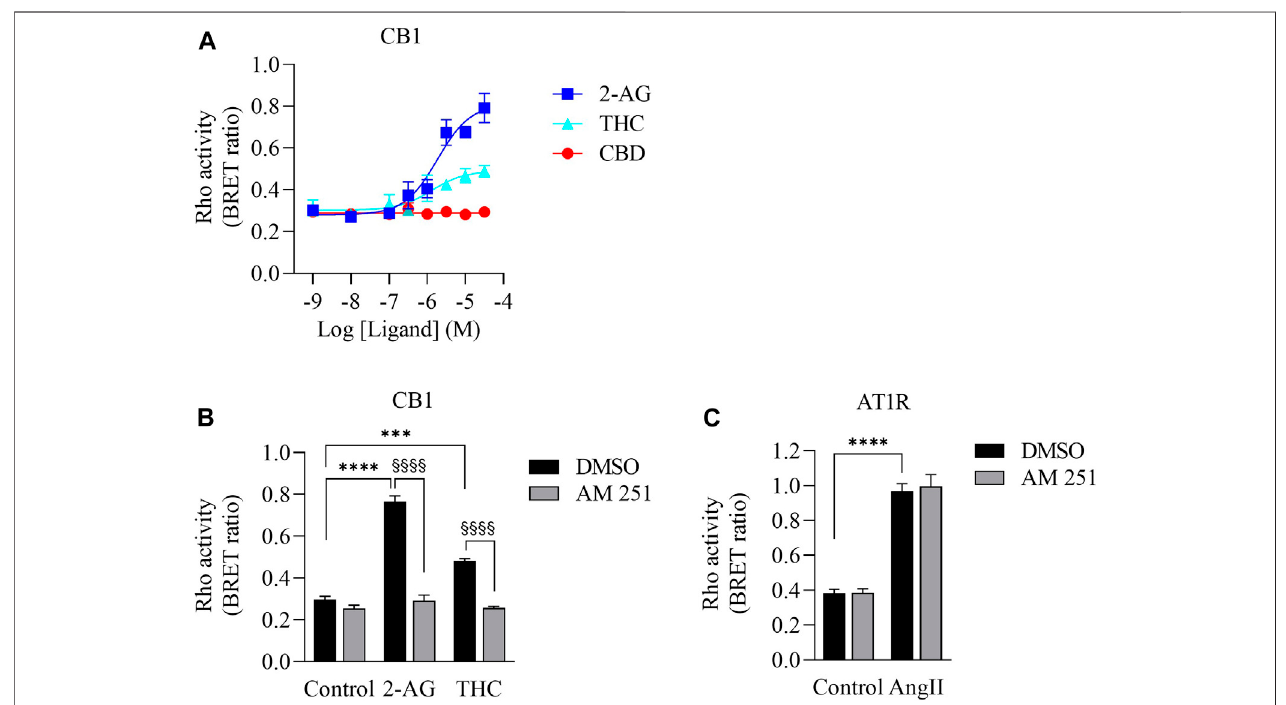
FIGURE 2 | Validation of CB1-mediated Rho activation. (A) . Concentration response curves of Rho activation in HEK293 cells expressing CB1, PKN-RBD-RLucII and rGFP-CAAX. Cells were stimulated with either 2-AG (blue square), THC (turquoise triangle) or CBD (red circle). CB1 was activated with 2-AG and Δ 9 -THC but not withCBD.Datarepresentmeans±SEMoffourindependentexperimentsperformedintriplicate. (B) .ValidationofCB1-mediatedRhoactivationbyCB1antagonistAM- 251. Cells were stimulated with control, 2-AG (10 µM) or Δ 9 -THC (THC, 10 µM) in the absence (vehicle, 0.1% DMSO (black bar)) or presence of 10 µM of AM-251 (greybar).TherewasanincreaseinRhoactivationincellsexposedto2-AG(**** p < 0.0001)and Δ 9 -THC(*** p < 0.0002).AM251abolished2-AG-andTHC-inducedCB1 activation ( §§§§ p < 0.0001). (C) . Cells expressing AT1R, PKN-RBD-RLucII and rGFP-CAAX were stimulated with control or with 100 nM of AngII, agonist for AT1R, with 0.1% of DMSO (black bar) or 10 µM ofAM-251 (grey bar). There was an increase in AT1R-mediated Rho activation in cells exposed to AngII (**** p < 0.0001). There was no effect of AM251 on AT1R-mediated Rho activation. Data represent means ± SEM of three independent experiments.